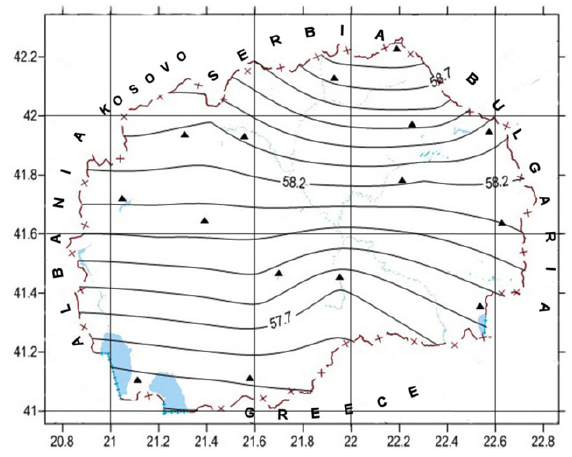
Figure 3. Map of the inclination I for the 2010.0 epoch. Figure 2. Map of the declination D for the 2010.0